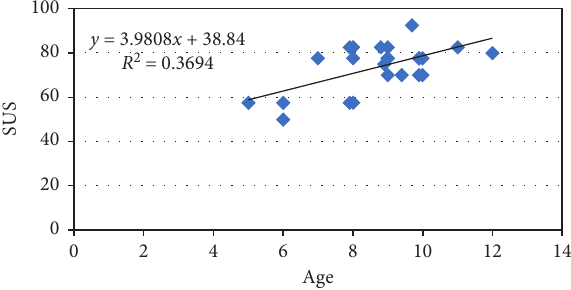
Figure 9: Satisfaction.